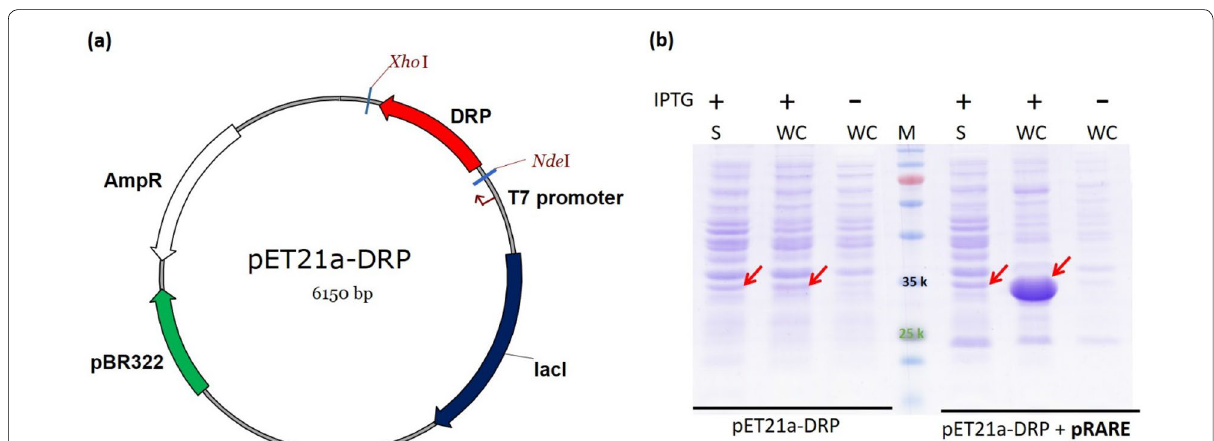
Fig. 2 a Gel electrophoresis analysis of DRP sequence by colony PCR. The N1 and N2 was the negative control by E. coli and pET21a( in the PCR reaction. The P indicates the positive control with DNA synthesis of DRP as a template, while numbers 1–4 represent each colony from pET21a‑DRP in E. coli . M is the molecular weight of DNA marker. The targeted size is 832 bp. b DRP and DRP co‑expression with pRARE vector for rare‑codon optimization by SDS‑PAGE analysis. S and WC represent the proteins from soluble and whole cell. The red arrows indicate the size of DRP